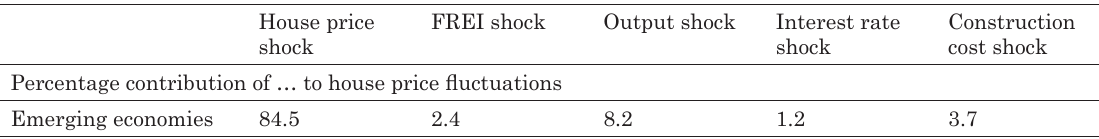
Table 6. Variance